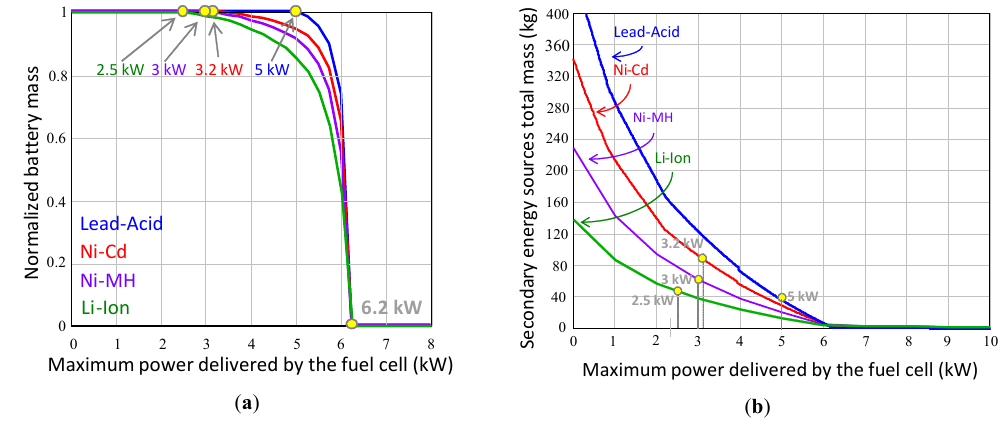
Figure 14. Mass of the battery and the secondary sources when lithium-ion, lead–acid, nickel–metal hydride, and nickel–cadmium batteries are used, considering the same vehicle with the ECE-15 driving profile and a variation in the state-of-charge of 75%. ( a ) Normalized battery mass. ( b ) Total mass of secondary energy sources.